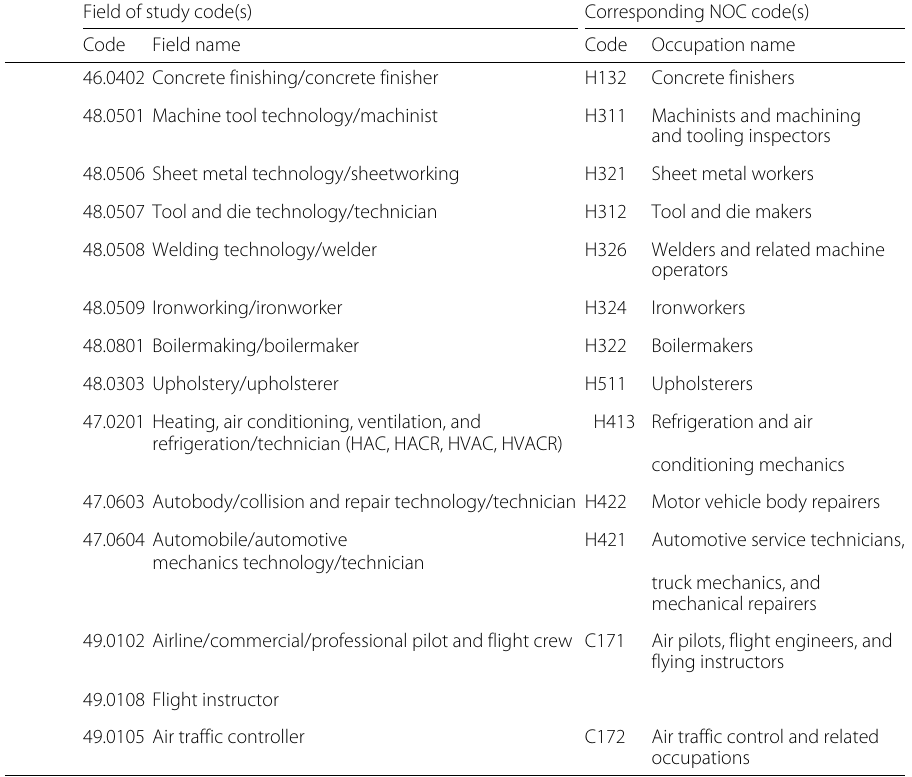
Table 16 Specialized occupation and field of study matches ( Continued )